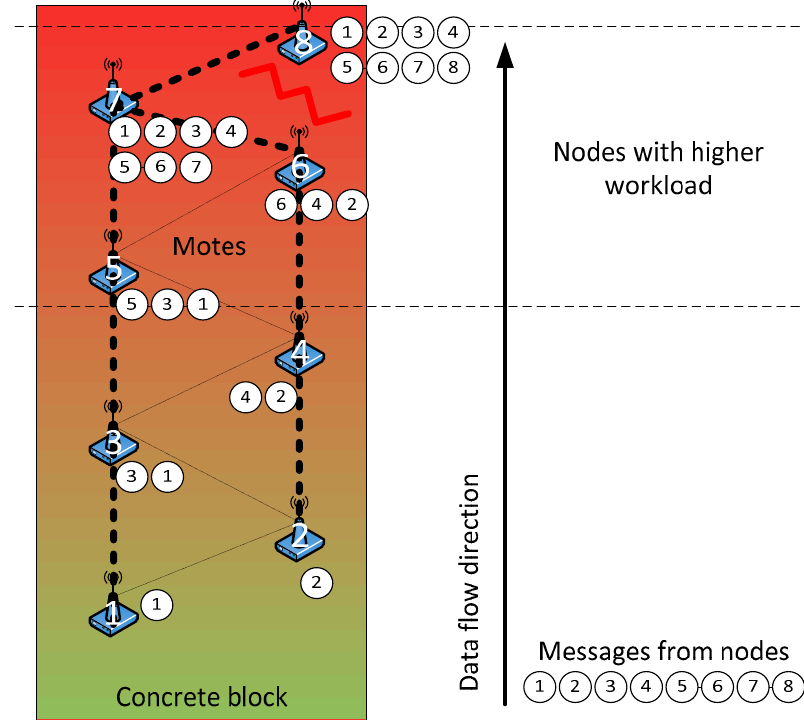
Figure 1. Network topology and associated problems.